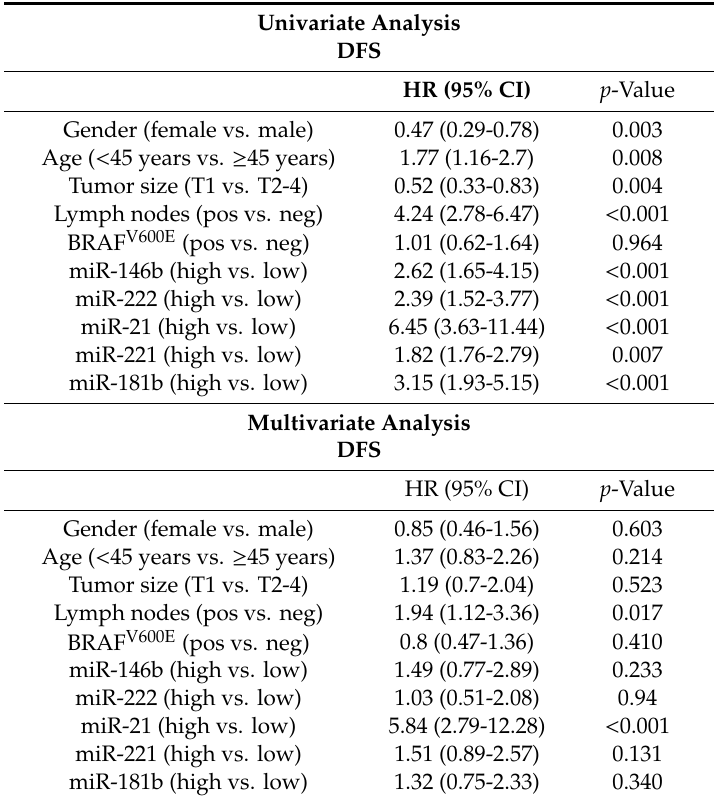
Table 3. Univariate and multivariate analysis of disease-free survival (DFS) in patients with PTC. Cox proportional regression hazard model was